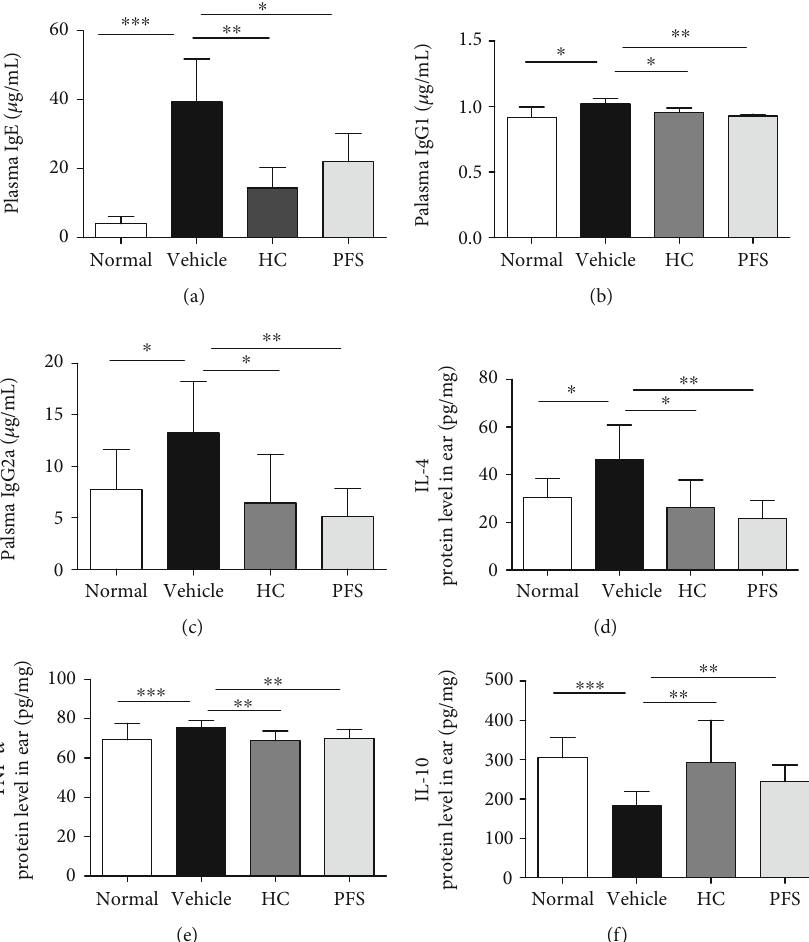
Figure 4: E ff ects of PFS on the production of IgE and skin in fl ammation in oxazolone-induced dermatitis (ten-time challenge). Data are expressed as mean ± SD ( n = 6 ). ∗ p < 0 : 05 and ∗∗ p < 0 : 01 compared with the vehicle